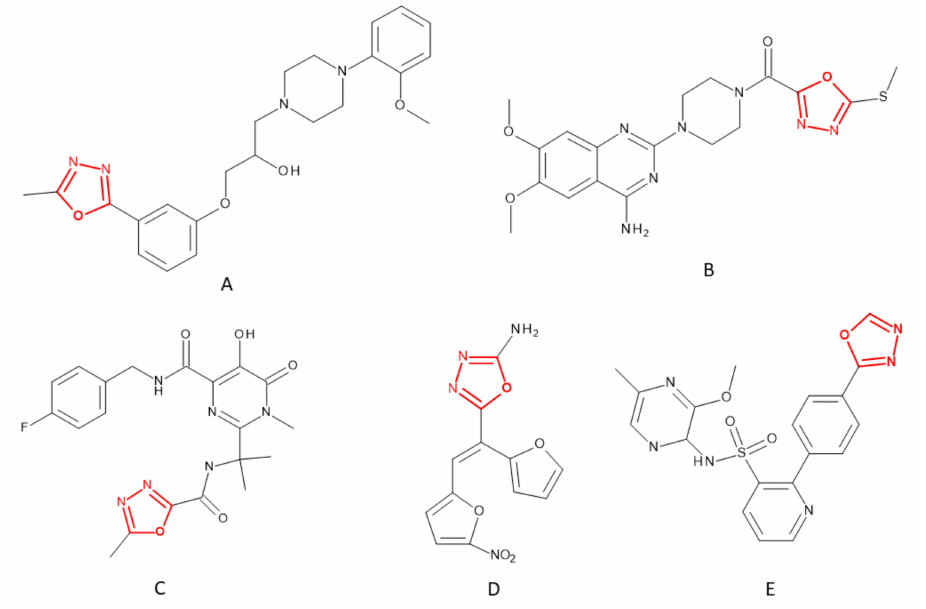
Figure 1. Chemical structures of some approved 1,3,4-oxadiazole ring-based drugs: Furamizole ( A ), Nesapidil ( B ), Raltegravir ( C ), Tiodazosin ( D ) and Zibotentan ( E